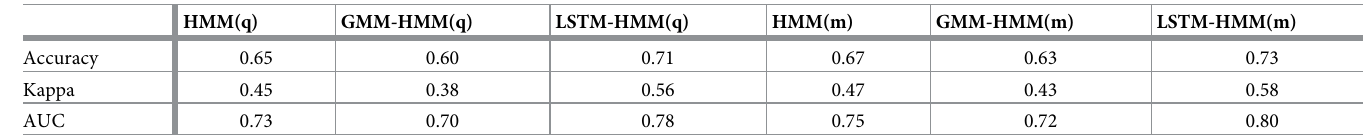
Table 13. Accuracy, kappa and AUC for HMM, GMM-HMM and LSTM-HMM with monthly or quarterly input and 8-year time window.